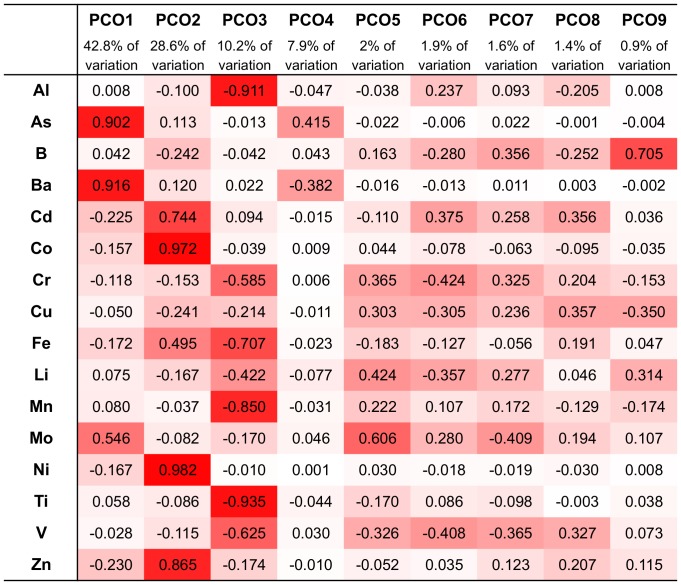
Sponge samples elemental correlation with PCOI vectors (R values), red highlight marks high correlation.